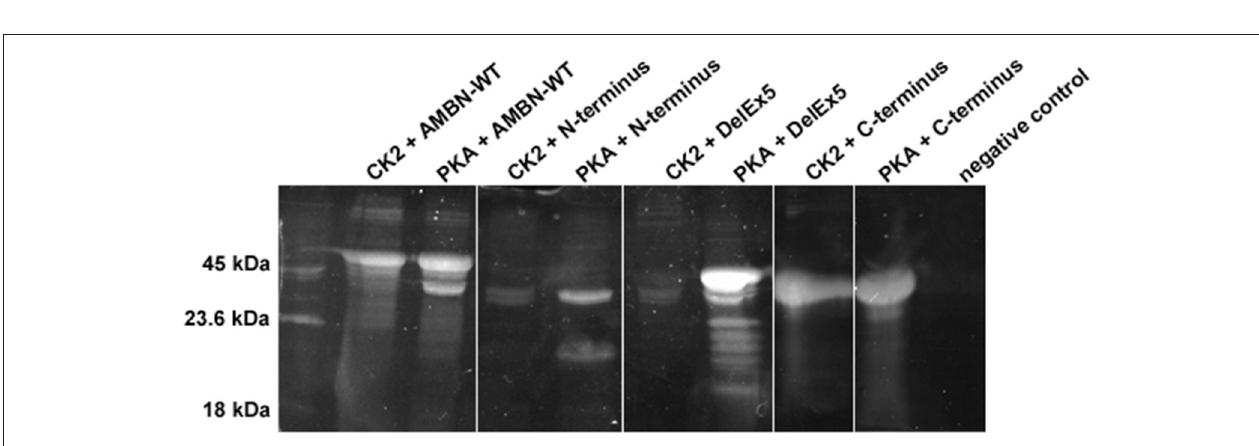
FIGURE 3 | Composite image representative of phosphorylated AMBN proteins and peptide by casein kinase2 (CK2) and protein kinase A (PKA). C-terminus, and AMBN-WT, N-terminus, and DelEx5 was phosphorylated by CK2 or PKA for 24 h, separated in 12% SDS-PAGE, and stained by ProQ diamond phosphorous stain. The intensity of bands between lanes can be interpreted as a semi-quantitative measurement of phosphorylation.